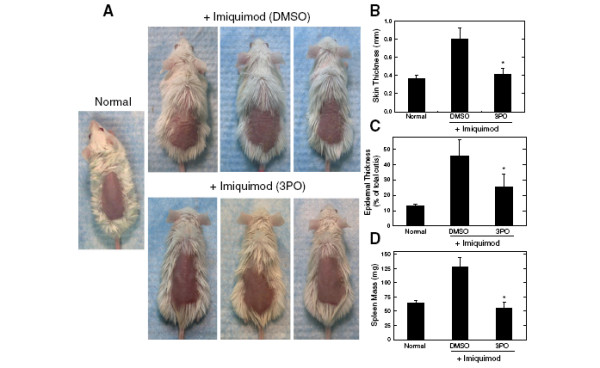
Intraperitoneal administration of 3PO suppresses the development of imiquimod-induced psoriasis. (A) Three BALB/c mice were administered a daily topical dose of 62.5 mg of imiquimod cream (5%) over a shaved area on the back for 5 days. Thirty minutes following each daily administration of imiquimod, the mice were injected intraperitoneally with either DMSO or 3PO 0.07 mg/gm daily. After 5 days, photographs were taken that demonstrate gross skin folds (i.e. wrinkling), scaling and erythema. A photograph was captured of a shaved mouse that had not been treated with imiquimod (Normal). (B), After 5 daily topical applications of imiquimod, skin thickness was measured using microcalipers. (C) After 5 daily topical applications of imiquimod, the epidermal thickness relative to the total cutis was determined. (D) After 5 daily topical applications of imiquimod, spleens were resected and mass was determined. Data from nine mice were averaged from three independent experiments (n = 3 per experiment). *p < 0.05 (relative to vehicle control). Data are representative of three independent experiments.